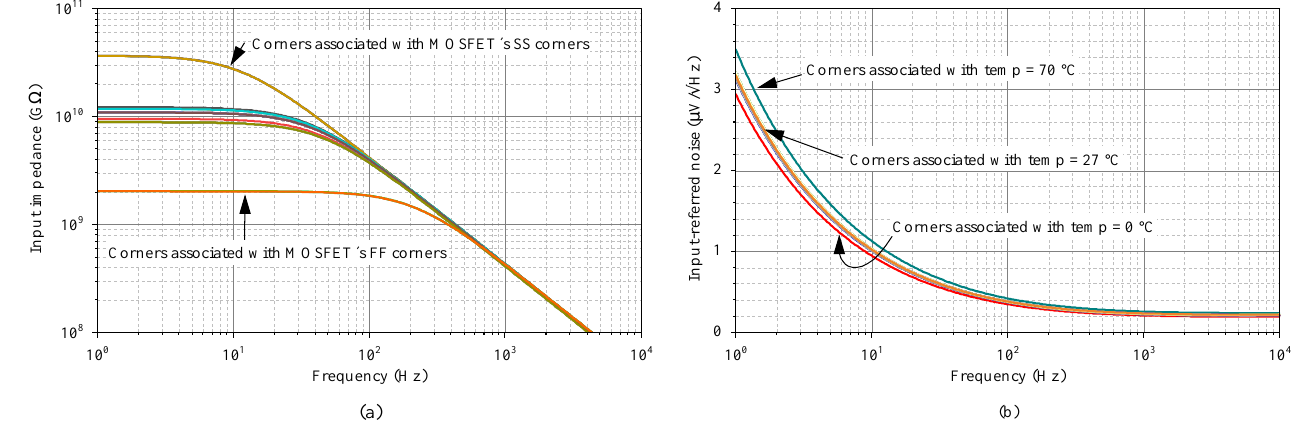
Figure 14. Frequency response of ( a ) the input impedance and ( b ) the input-referred noise in different PVT